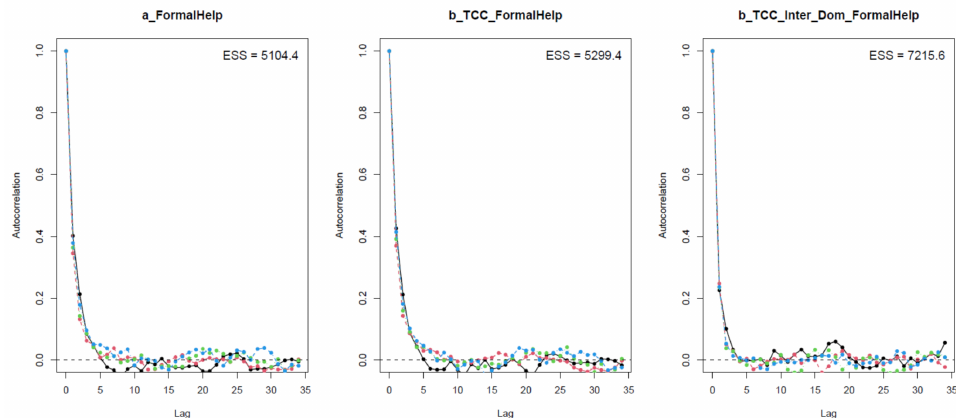
Figure A6. Autocorrelation plots for Model 3 (cid:48) s posterior coefficients.